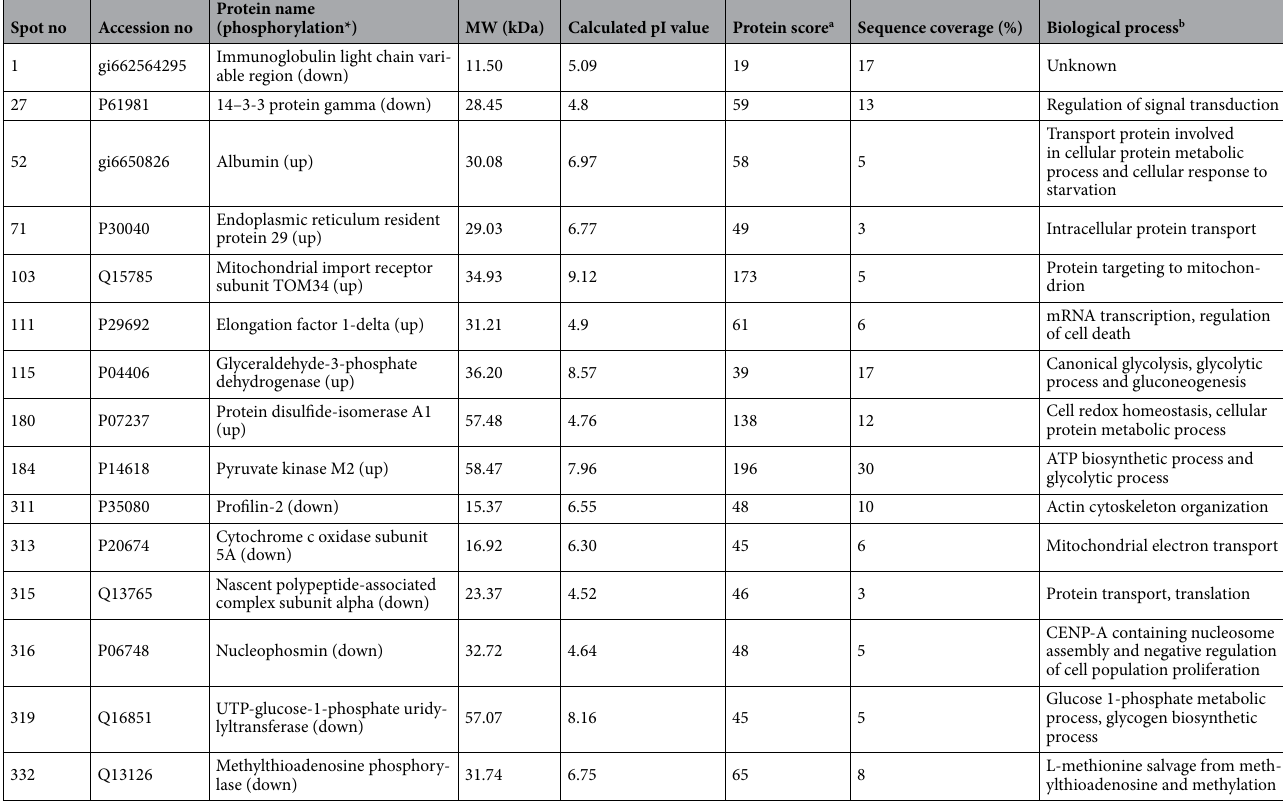
Table 1. Phosphoproteins of U937 during ADE infection identified by LC–MS/MS after Pro-Q Diamond staining of 2DE separated enrichment fractions. *Up (phosphorylation increased in DENV infection), down (phosphorylation decreased in DENV infection). a Protein score is an ion score obtained from the analysis with Mascot software. Ions score is − 10 * Log( P ), where P is the probability that the observed match is a random event. Protein score indicates the confidence of the protein identification; score value greater than 30 was considered significant ( P < .05). b Biological process information obtained from UniProt databases (https :// www.unipr